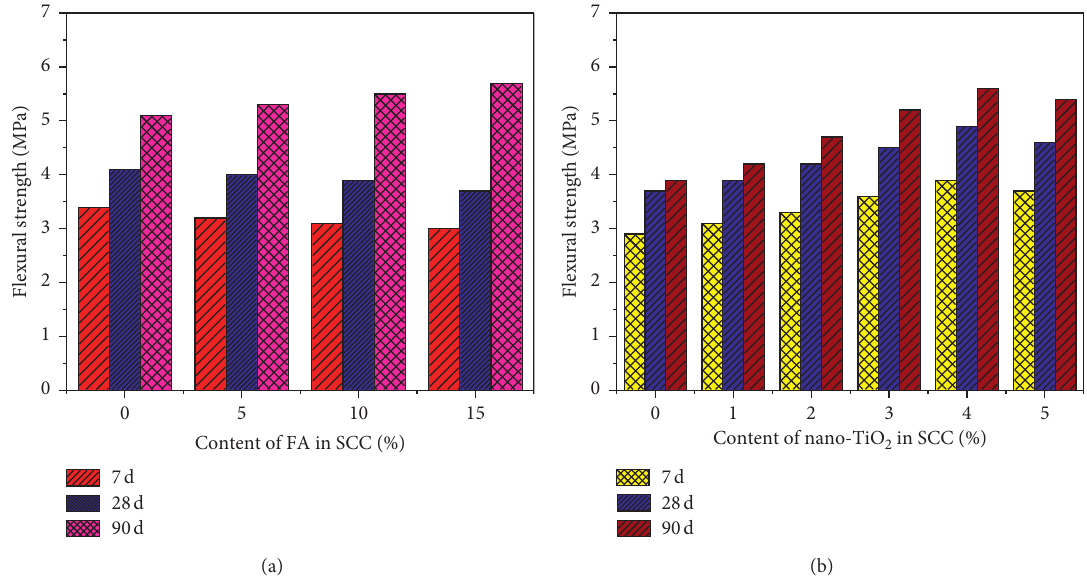
Figure 20: Flexural strength results of SCC-FA mixtures (a) and SCC-NT mixtures (b) [104]. (a) Content of FA in SCC, (b) Content of NT in SCC.